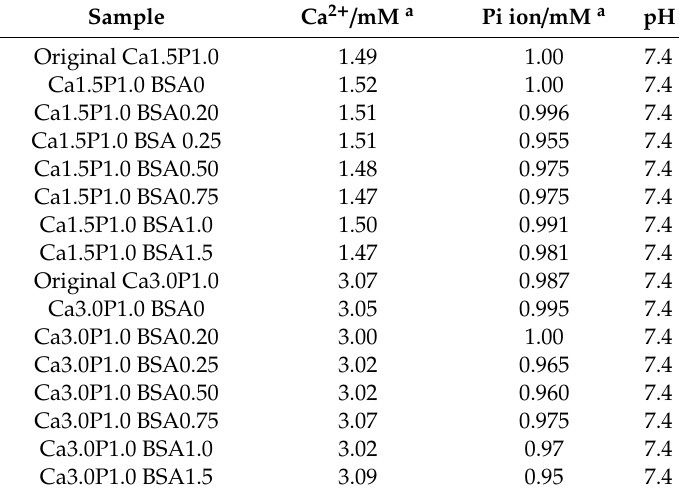
Table 1. Concentration of Ca 2 + and Pi ions in Ca1.5P1.0 and Ca3.0P1.0 solution before and after 1 h of incubation without OCP.